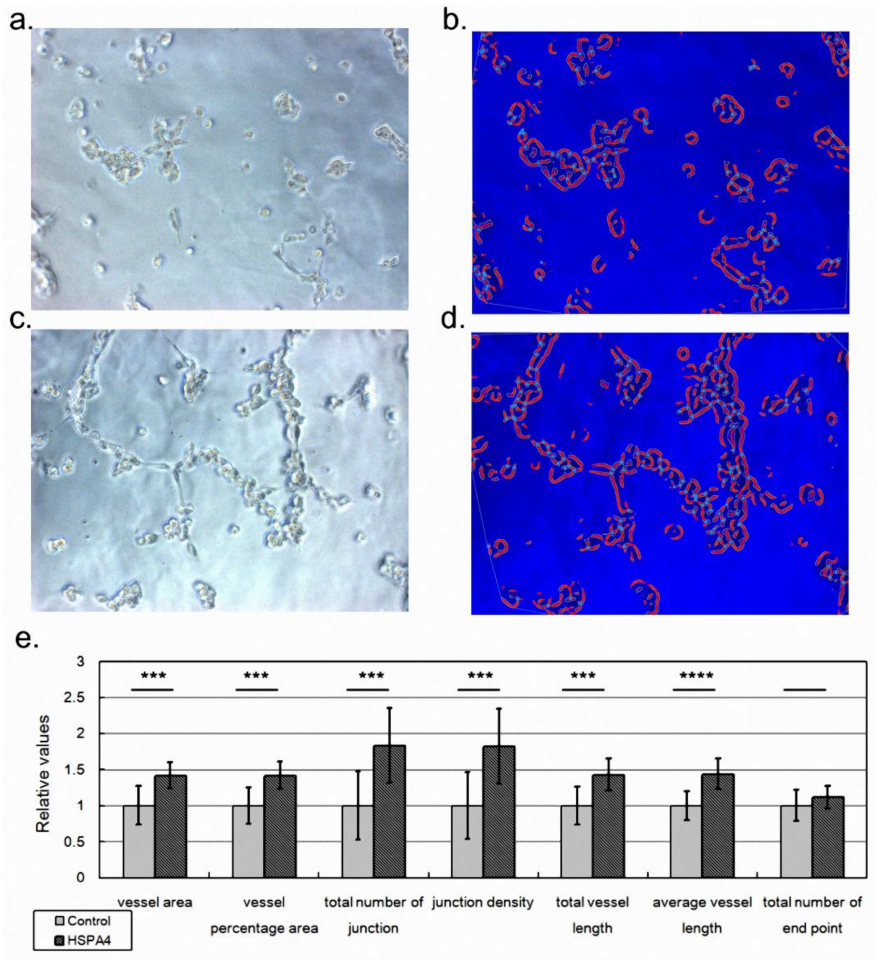
Figure 5. The results of the tube formation assay. We applied a tube formation assay to investigate whether HSPA4 promoted the angiogenesis ability of HUVECs. The cell growth morphologies of HUVECs transfected with empty pcDNA3.1 construct ( a , control set) or with HSPA4 expression construct ( b , HSPA4 set). ( c , d ) AngioTool analyzed the cell growth morphology and marked the vessels (the thick red lines), highlighted the junctions (the light blue points), and depicted the outlines of vessels (the thin orange lines). ( e ) By analyzing 12 pictures from four independent assays (four independent assays/wells * three pictures), we evaluated the angiogenesis ability by comparing these values. For simplicity, the values in the control set were normalized as one. Data was presented as the mean ± S.D. *** and **** denoted p -value < 0.001 and p -value < 0.0001,